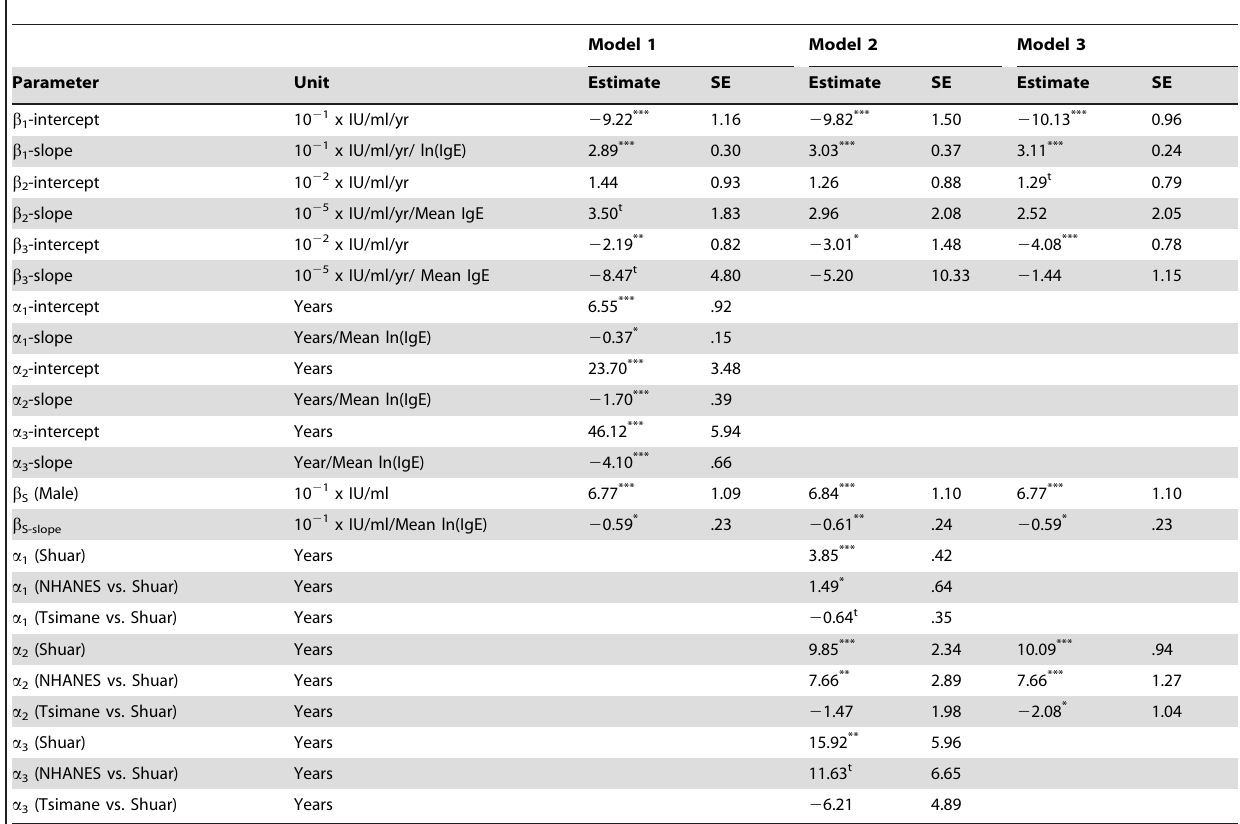
Table 3. Four models comparing age profile parameters among NHANES, Shuar, and Tsimane.